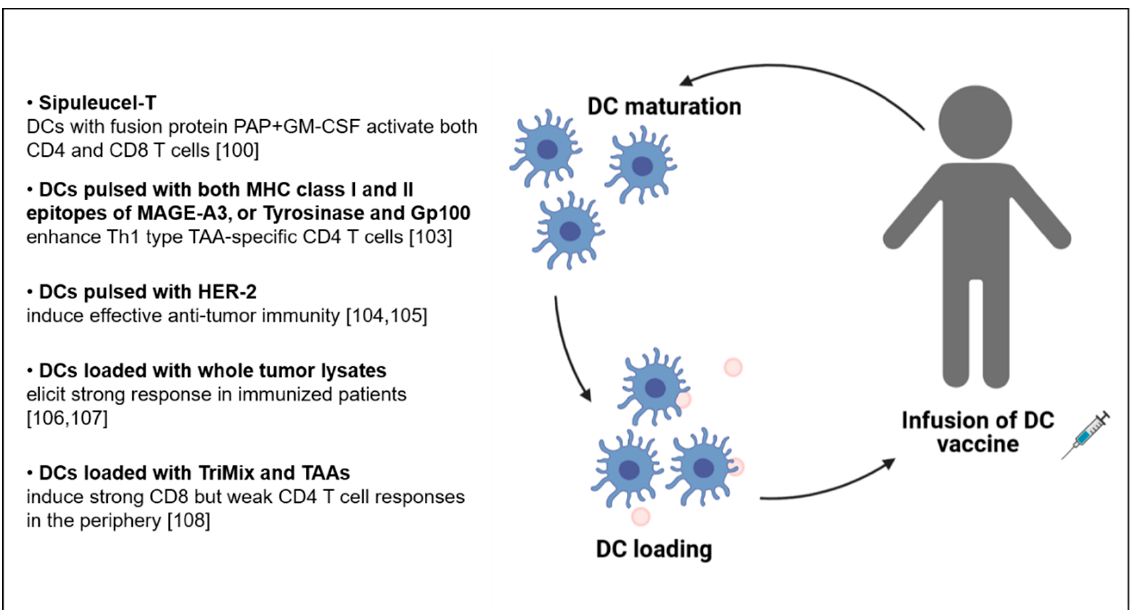
Figure 3. Summary of (DC)-based vaccinations for CD4 T cell activation.